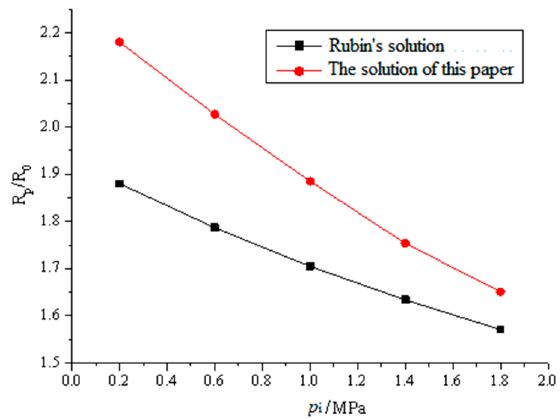
Figure 8. Plastic range under different support resistances.